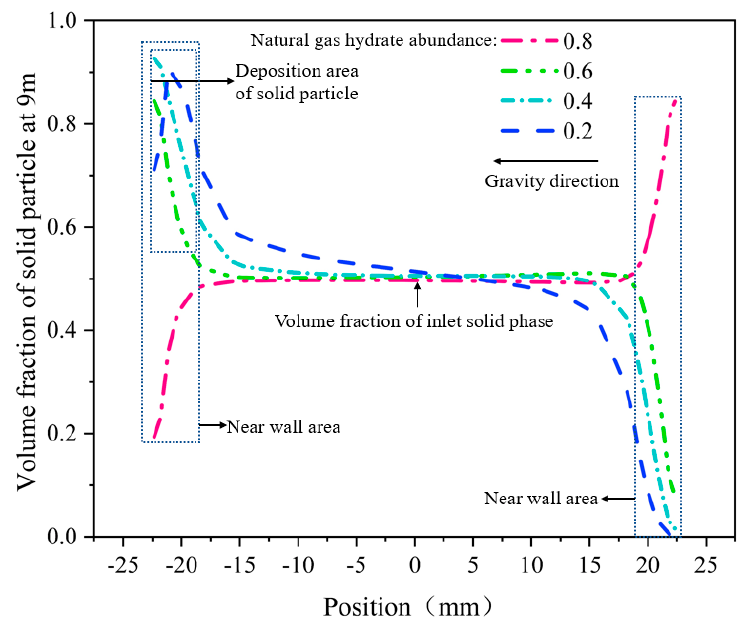
Figure 8. E ff ect of natural gas hydrate (NGH) abundance changes on the migration process of Figure 8. Effect of natural gas hydrate (NGH) abundance changes on the migration process of solid solid particles. particles.